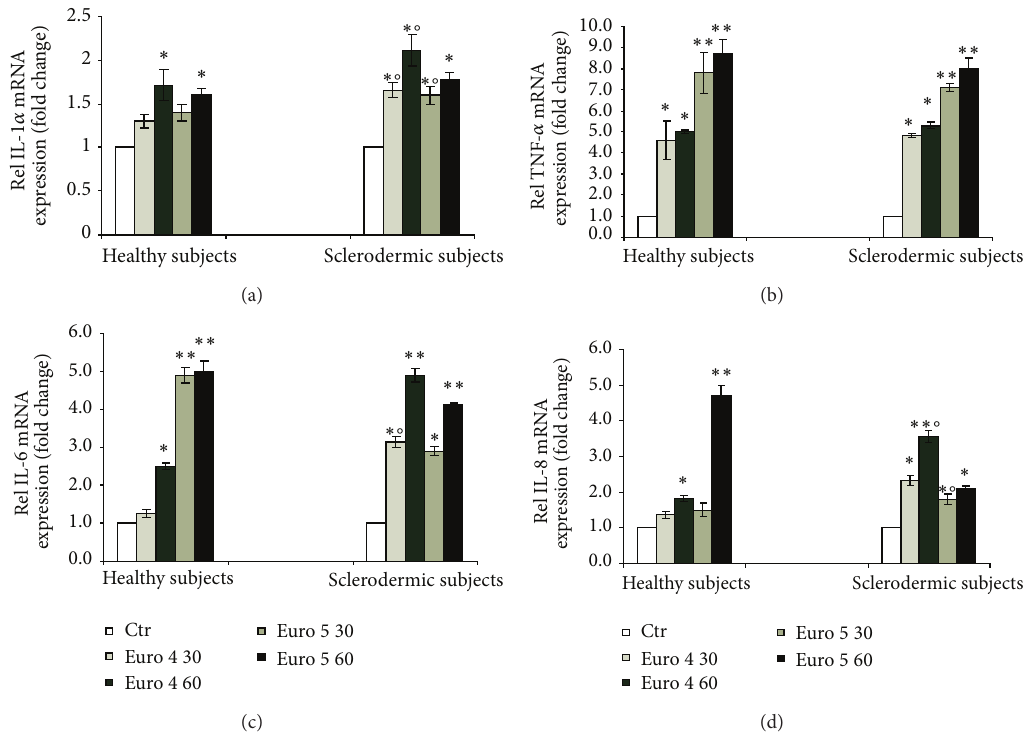
Figure 3: Real time PCR analysis of the expression of IL-1 𝛼 (a), TNF- 𝛼 (b), IL-6 (c), and IL-8 (d) in primary cultures of keratinocytes from sclerodermic and healthy subjects stimulated with Euro 4 and Euro 5 nanoparticles (30 and 60 𝜇 g/mL) for 6 h. ( ∗ 𝑃 < 0.01 and ∗∗ 𝑃 < 0.001 versus control; ∘ 𝑃 < 0.01 versus healthy